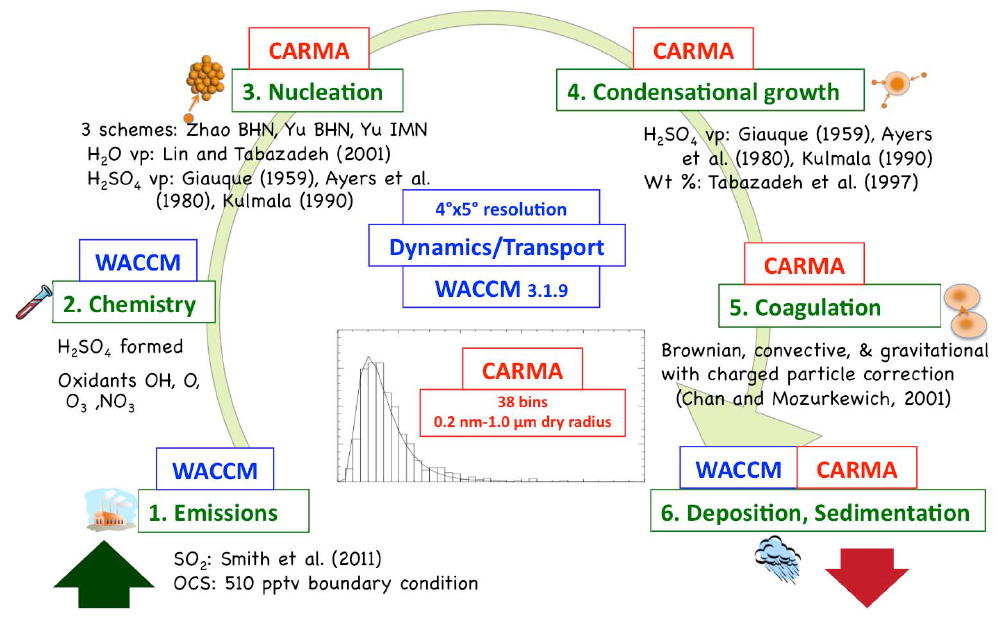
Fig. 1. Diagram of the WACCM/CARMA Model. WACCM simu- lates emissions, chemistry, dynamics and wet deposition. CARMA simulates nucleation, condensational growth, coagulation, and sed-